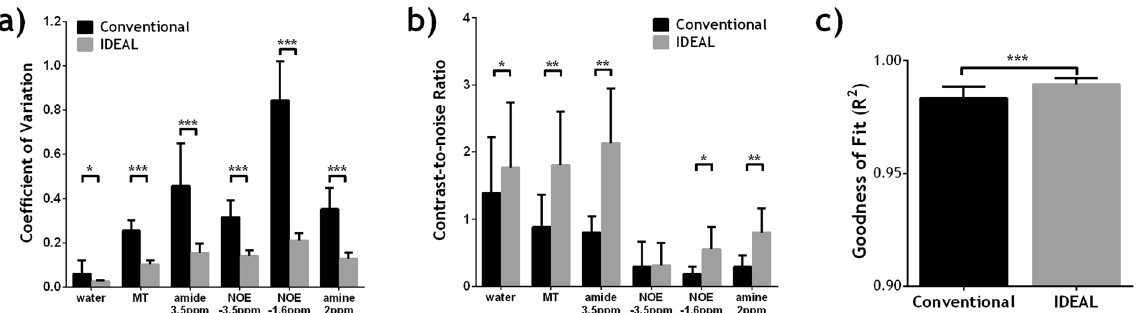
Figure 7. Comparison of fitting quality of conventional fitting and IDEAL fitting in rat gliomas (N = 8), including ( a ) the coefficient of variation (COV, i.e., S.D./mean) of the whole brain, ( b ) contrast-to-noise ratio (CNR) between the normal brain and brain tumor, ( c ) R 2 of the whole brain. Paired Student's t-test was performed between the two methods with * P < 0.05, ** P < 0.01 and *** P <